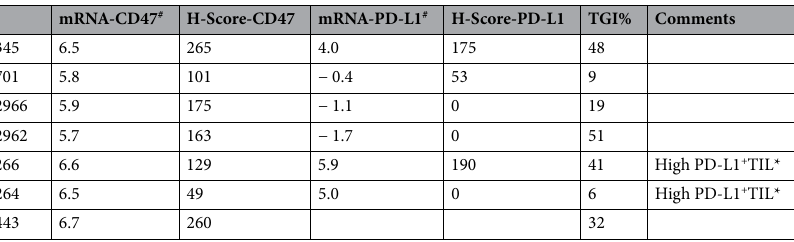
Table 2. Expression levels of CD47 and PD-L1 immune checkpoints in B-lymphoma PDXs as well as models’ sensitivity to HX009. IHC scores is based on tumor cell staining; *is based on non-tumor leukocyte staining. # The mRNA levels are represented in log2(FPKM) based on RNAseq dataset. FPKM: fragments per kilobase per million mapped reads. The lowest log2(FPKM) value as − 2. %: Tumor growth